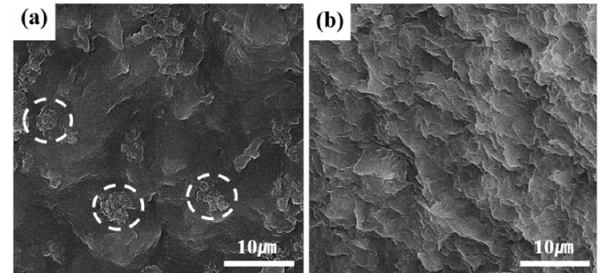
Figure 5. Scanning electron microscopy images for the inside of the dried alginate bead encapsulating ( a ) FKC + LDH and ( b ) FKC + KA mixture. The dashed circles indicated the location of the FKC + LDH agglomerates. To trace the FKC inside the alginate bead, the cells were labelled with FITC. In order to check that this FITC-FKC could be utilized in the quantification of FKC, the relationship between the FKC concentration and fluorescence intensity was fitted into a linear equation.